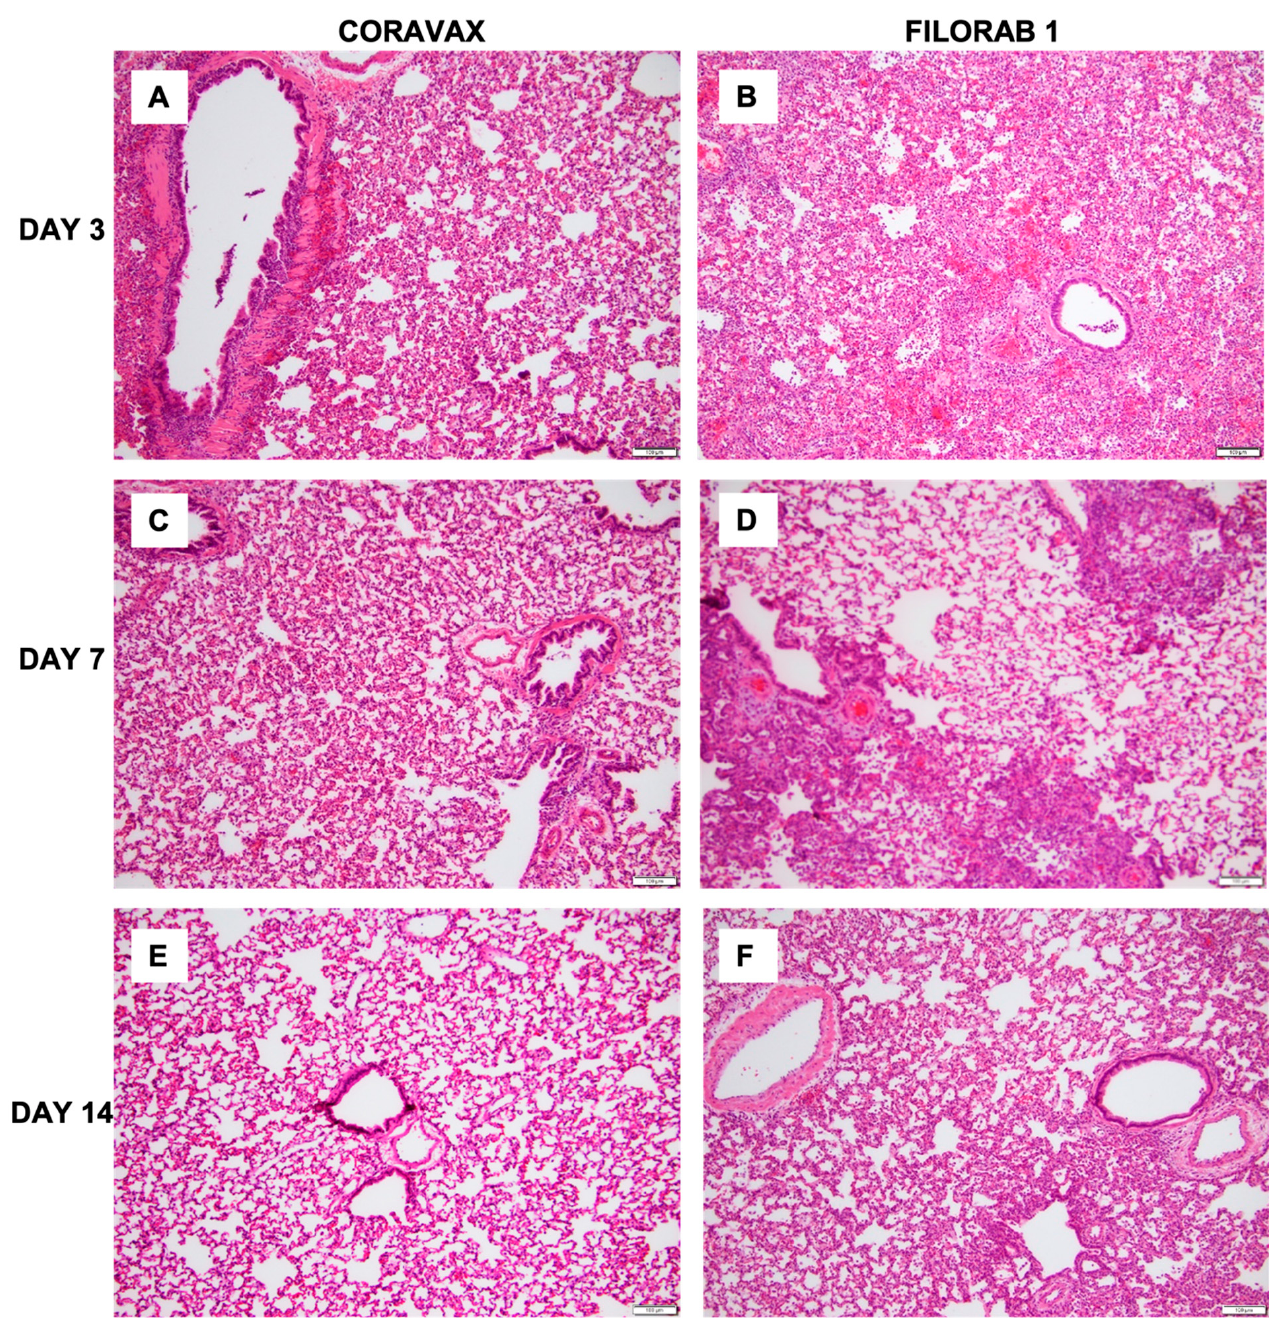
Figure 6. SARS-CoV-2 lung pathology. Representative histological images of SARS-CoV-2 infection in control and vaccinated hamster lungs. ( A , C , E ): CORAVAX vaccinated on days 3, 7, and 14 p.c. ( B , D , F ): FILORAB1 control on days 3, 7, and 14 p.c. All images were taken with 10× objective and 0.5 camera adaptor; the scale bar in every image equals 100 μ m. The images show significantly less lung inflammation in the vaccinated animals than in the control unvaccinated animals. The difference is more prominent on day 3 p.c., followed by day 7 p.c.